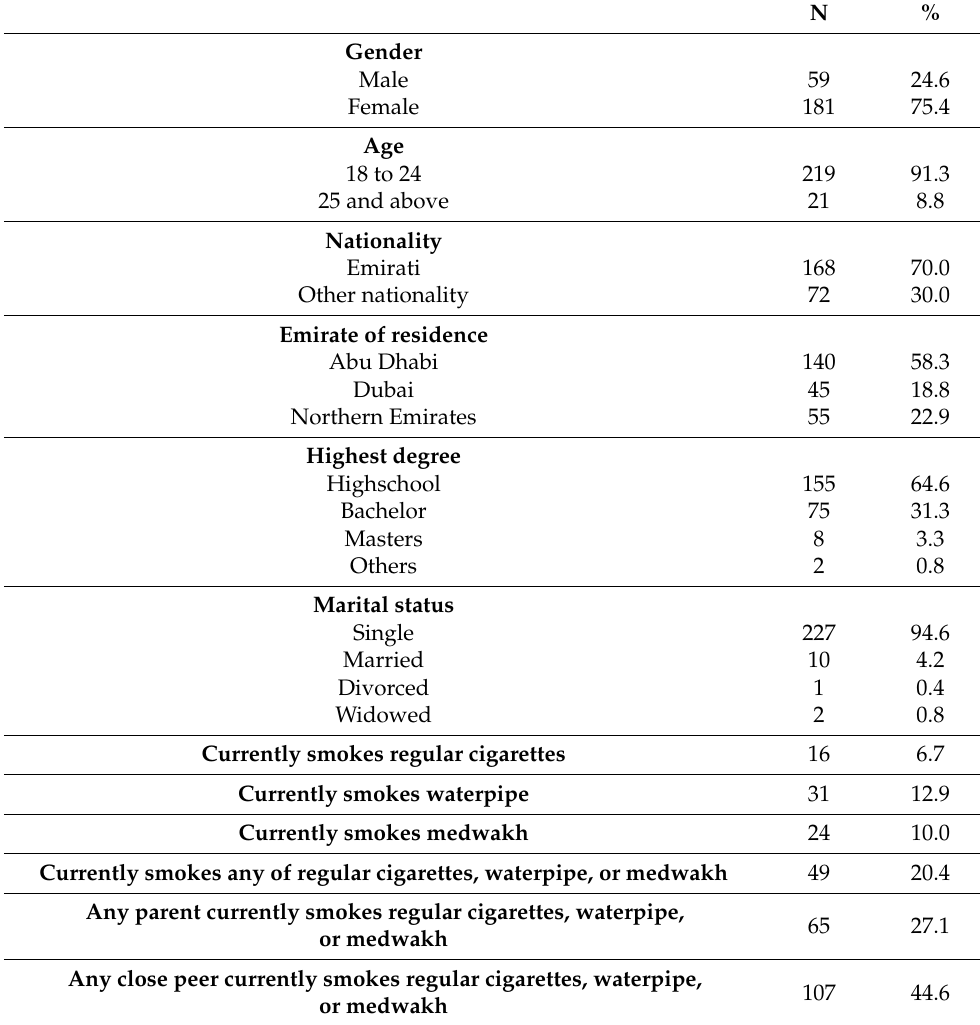
Table 1. Socio-demographic characteristics and current use of regular cigarettes, waterpipe, or medwakh ( n =